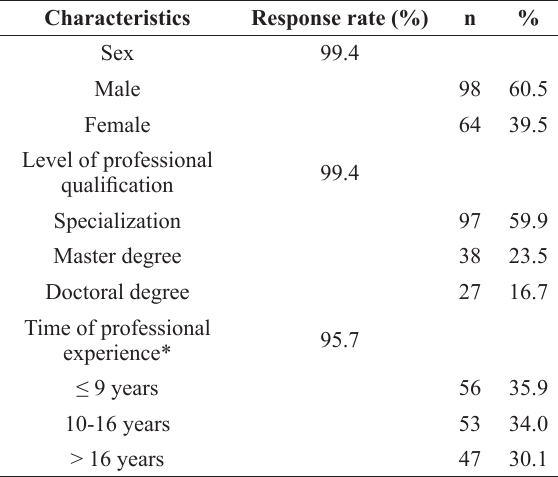
Characteristics of the orthodontists investigated in the present